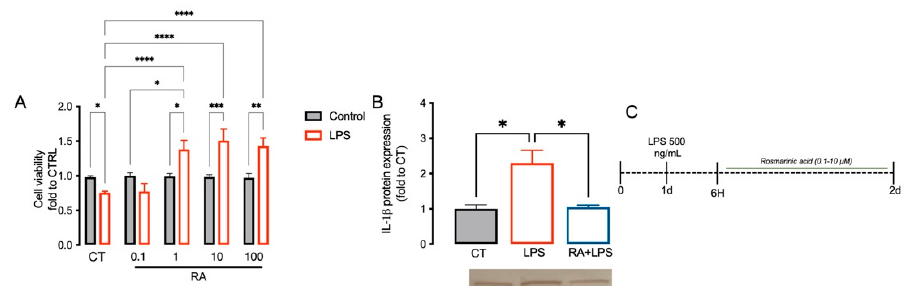
Figure 1. Effect of RA on LPS-stimulated BV2 cells. ( A ) Evaluation of the effect of rosmarinic acid (RA, 0.1–10 µM) on counteracting LPS-induced toxicity on BV2. One-way ANOVA **** p < 0.0001 *** p < 0.001 ** p < 0.01 * p < 0.05 ( n = 3). ( B ) Effect of RA 1 µM in reducing IL-1 β release in